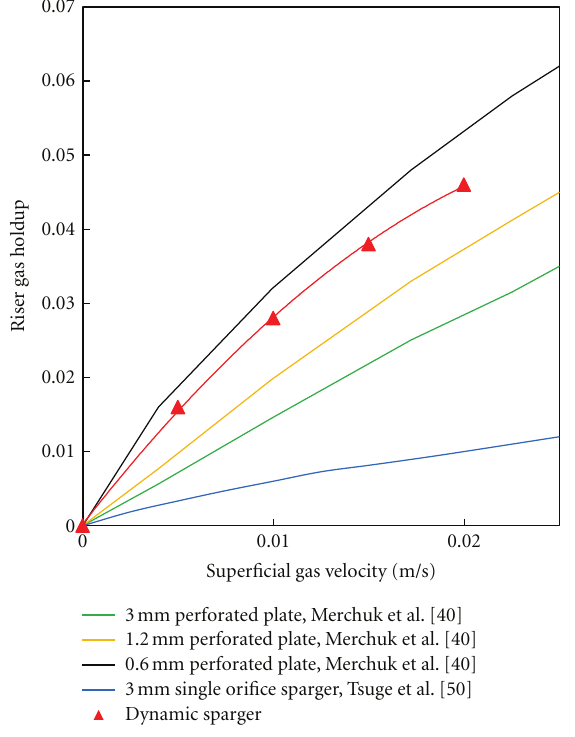
Figure 10: E ff ect of bubble size on the riser gas holdup ( U G = 0 . 008 ms − 1 , W L /W G =